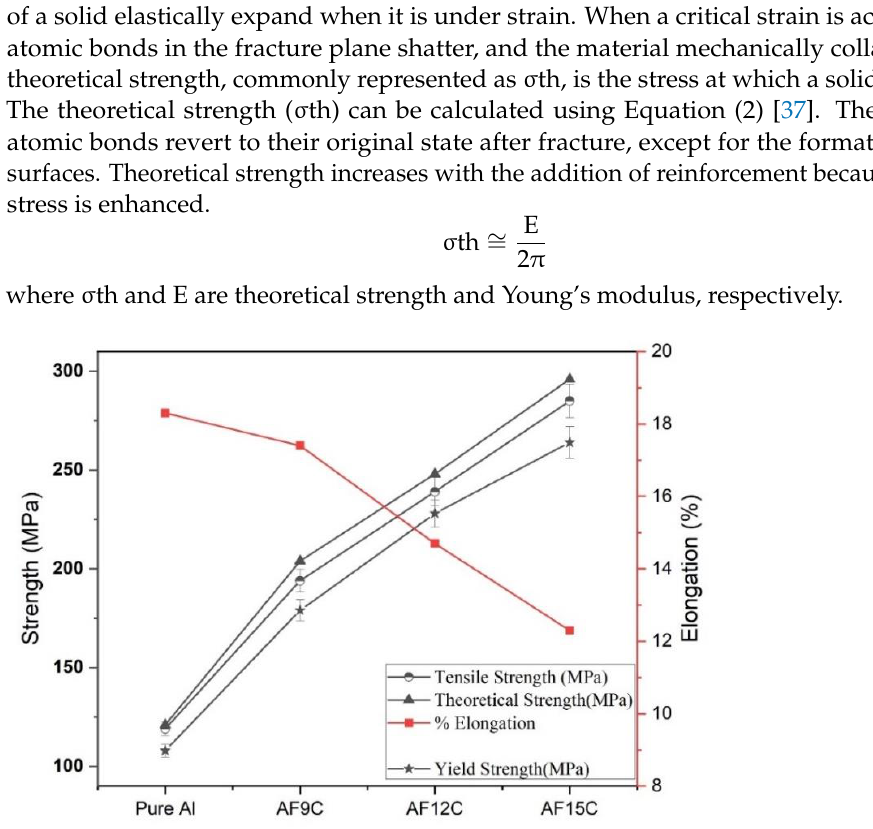
Figure 7. The measured density and porosity of nanocomposite.